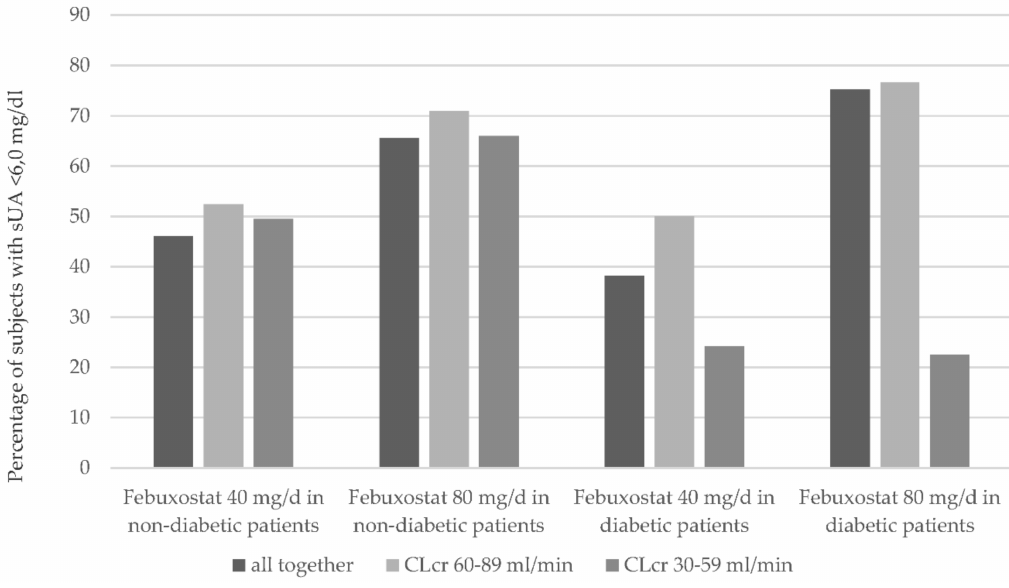
Figure 6. Comparing diabetic and non-diabetic patients and the urate lowering efficiency of febuxostat (patients with achievement of serum urate level < 6.0 mg/dL in percent) at a daily dose of febuxostat of 40 mg/day respectively 80 mg/day with regard to the renal function level (sUA: serum urate level) [56].